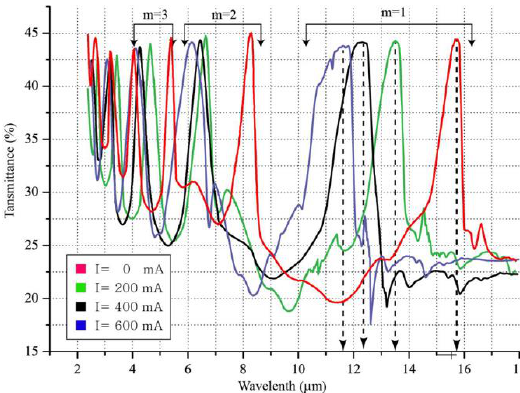
Figure 11. Comparison of infrared transmittance as a function of the applied current. Table 1. Summary of wavelength tuning performance.